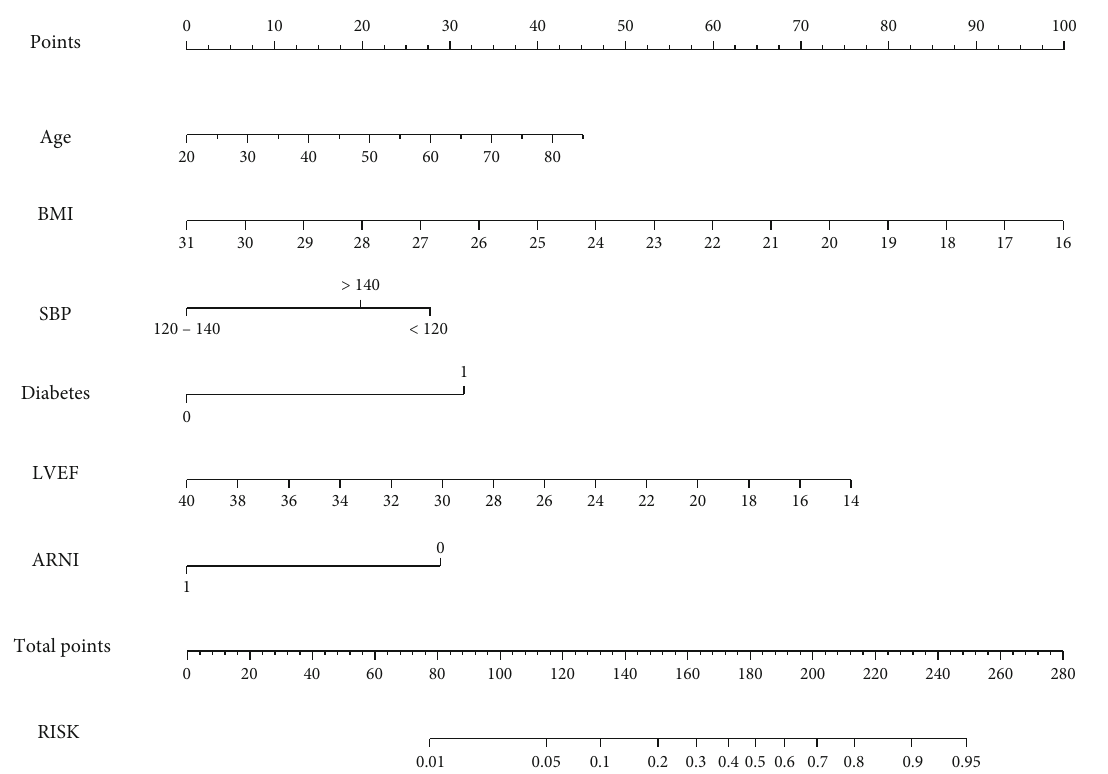
Figure 2: Nomogram used for predicting the risk of readmission in patients with HFrEF within 1 year. BMI: body mass index; SBP: systolic blood pressure; LVEF: left ventricular ejection fraction; ARNI: angiotensin receptor neprilysin